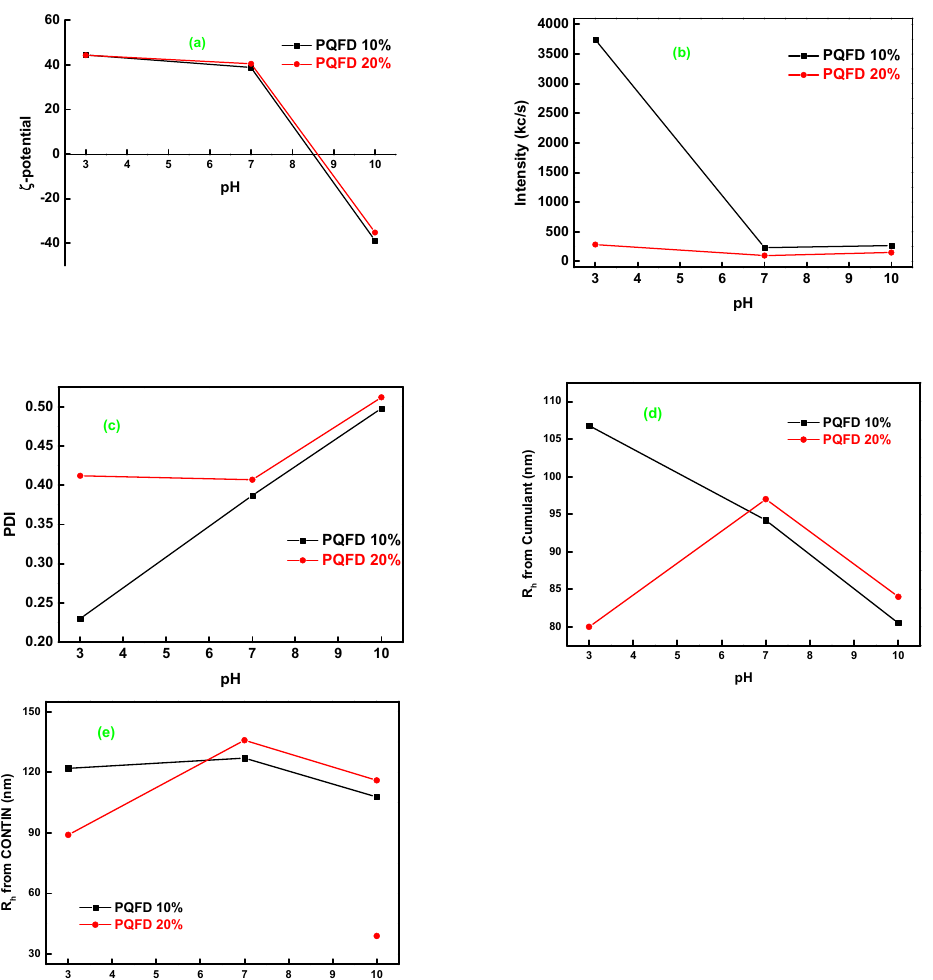
Figure 4. Dependence of ( a ) ζ − potential, ( b ) scattering intensity, ( c ) PDI, ( d ) R h (from cumulant method), and ( e ) R h (from CONTIN) of the PQFD 10% and PQFD 20% copolymer solutions (H 2 O protocol) on pH variations . Table 4. Effect of pH on the properties of copolymerPQFD 10% aqueous solutions . Preparation Protocol